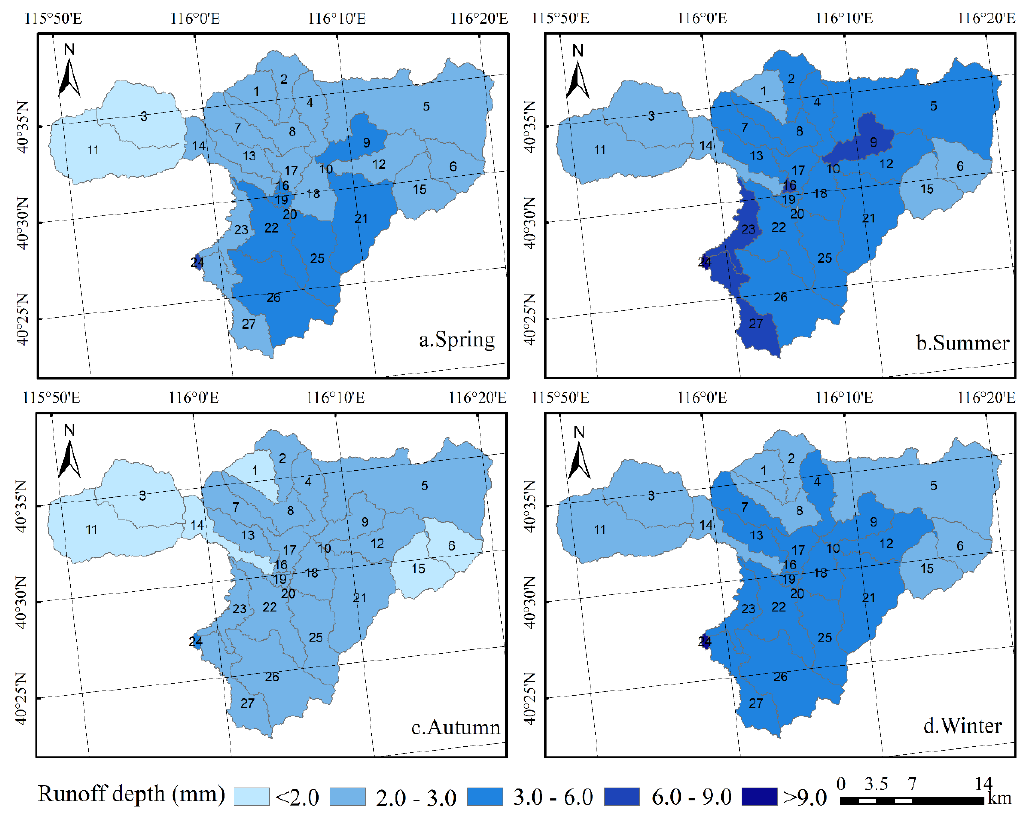
Figure 7. Spatial distribution of seasonal runoff depth in the Guishui River Basin.